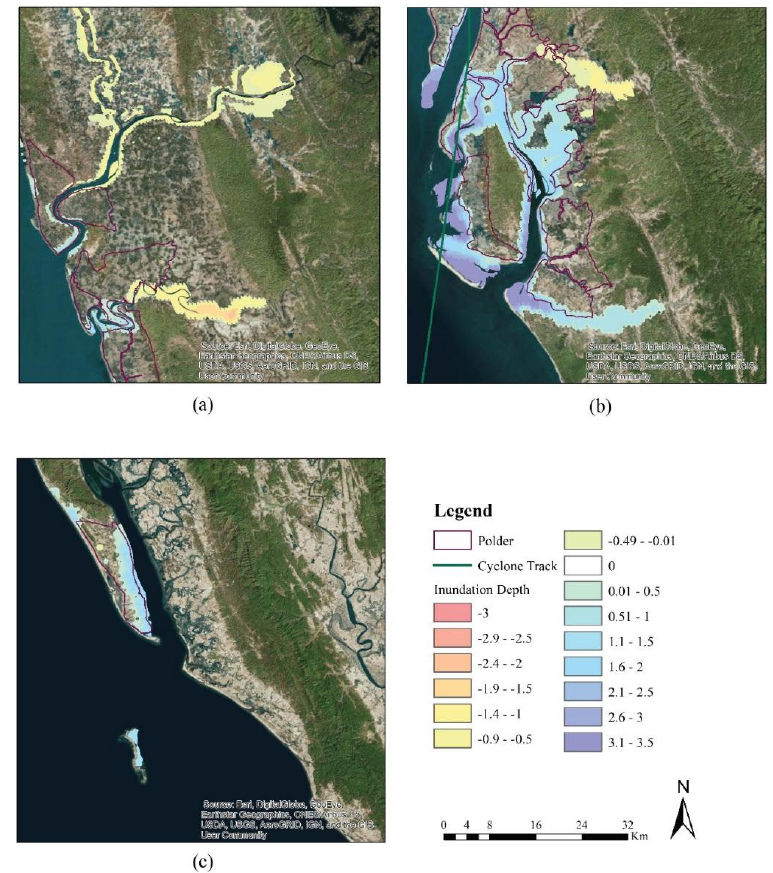
Figure 9. Changes in inundation extent during high tide compared to low tide at ( a ) Chittagong, ( b ) TC Mora landfall location, and at ( c ) Cox’s Bazar.